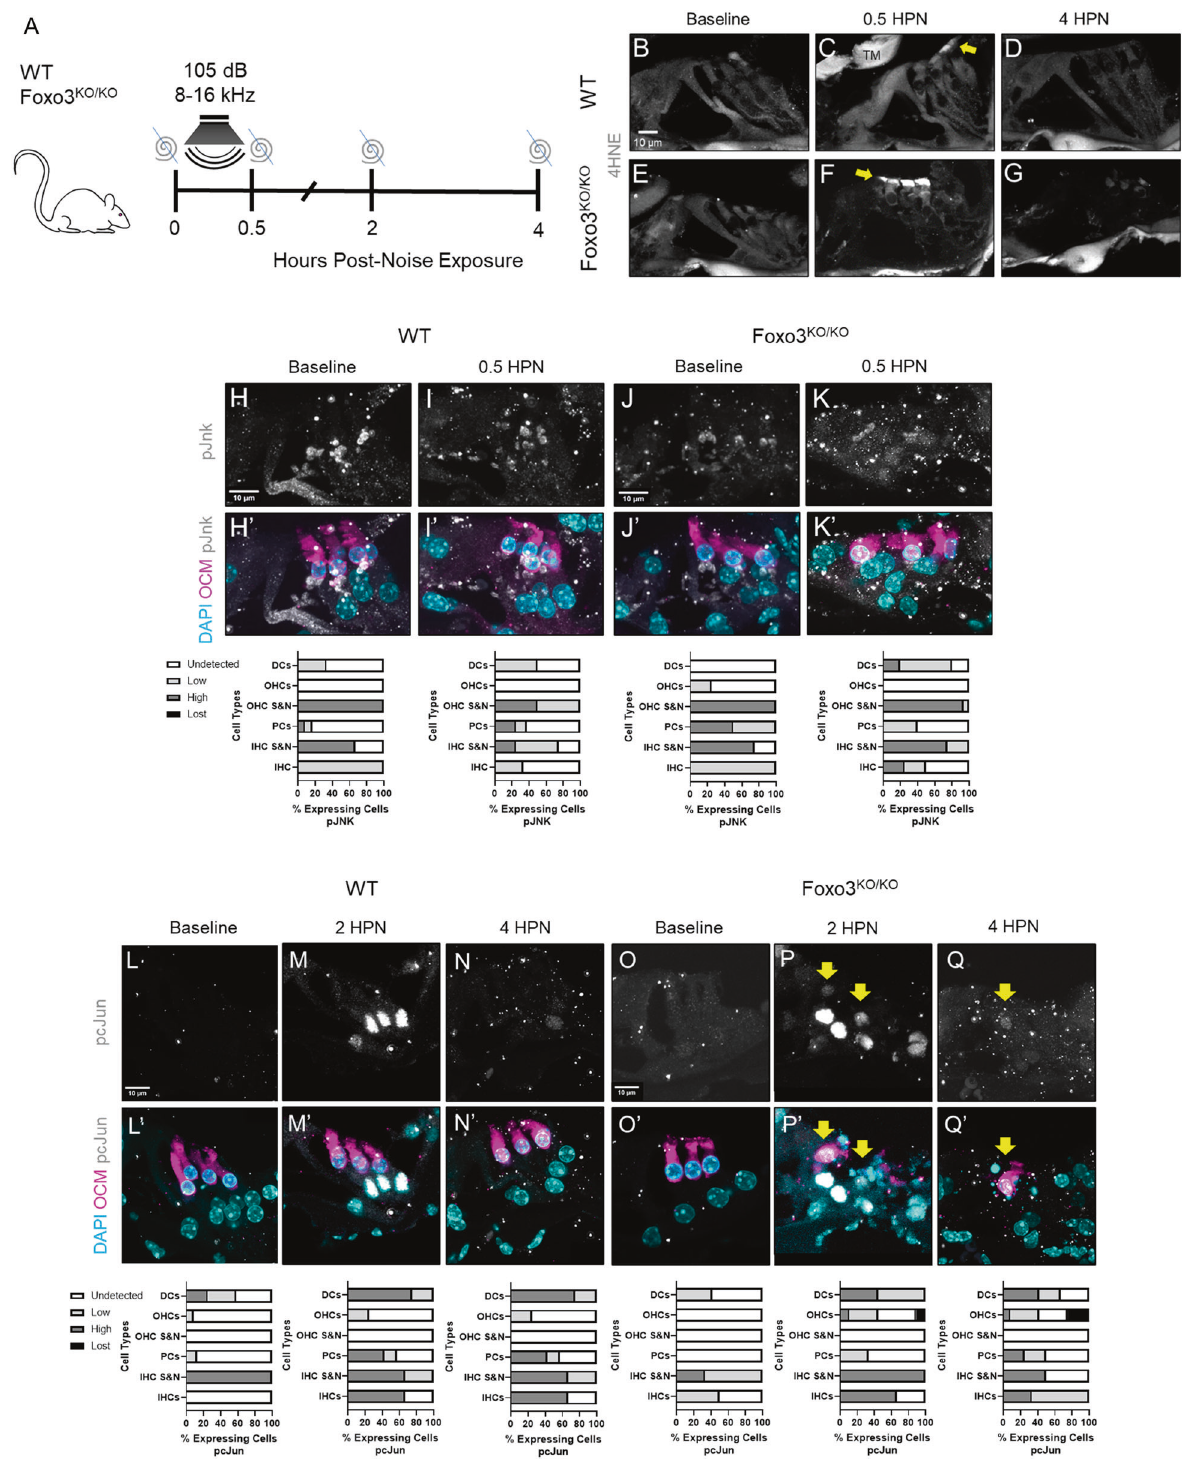
to baseline (Fig. 6M, p = 0.0495, two-way ANOVA). Identically poor DPOAEs were present in both Foxo3 − / − groups above 16 kHz at 14 DPN (Fig. 6N, 16 kHz p < 0.0001, 24 kHz p = 0.02, 32 kHz p = 0.03, two-way ANOVA). LPA treatment improved WT OHC function versus saline-treated mice at 32 kHz (Fig. 6N, p = 0.0004, Welch ’ s t -test). These results suggest that a brief LPA treatment delays rapid cell death in the Foxo3 − / − cochlea,